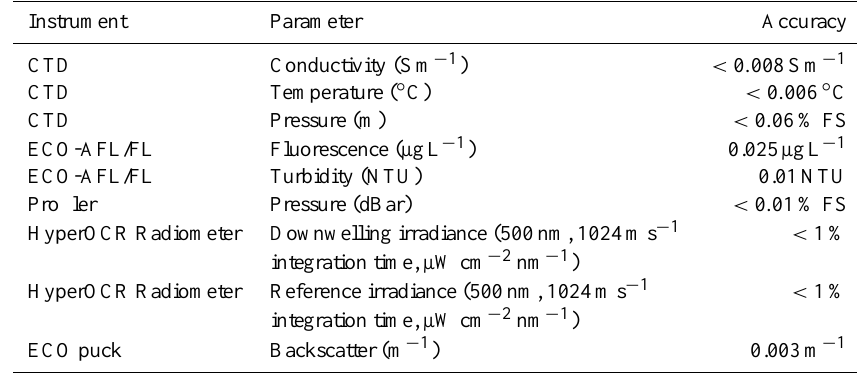
Table 1. Accuracy of in situ instruments used in this paper (FS: full